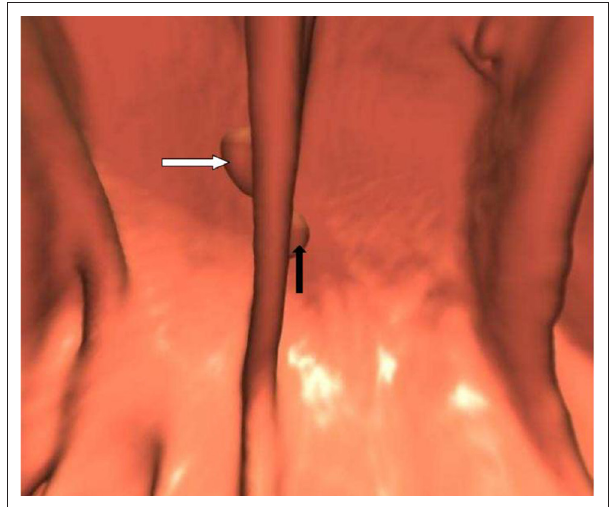
FIGURE 13: Sessile polyp on the posterior haustral fold (white arrow). There is a smaller sessile polyp on the anterior haustral fold (black arrow).